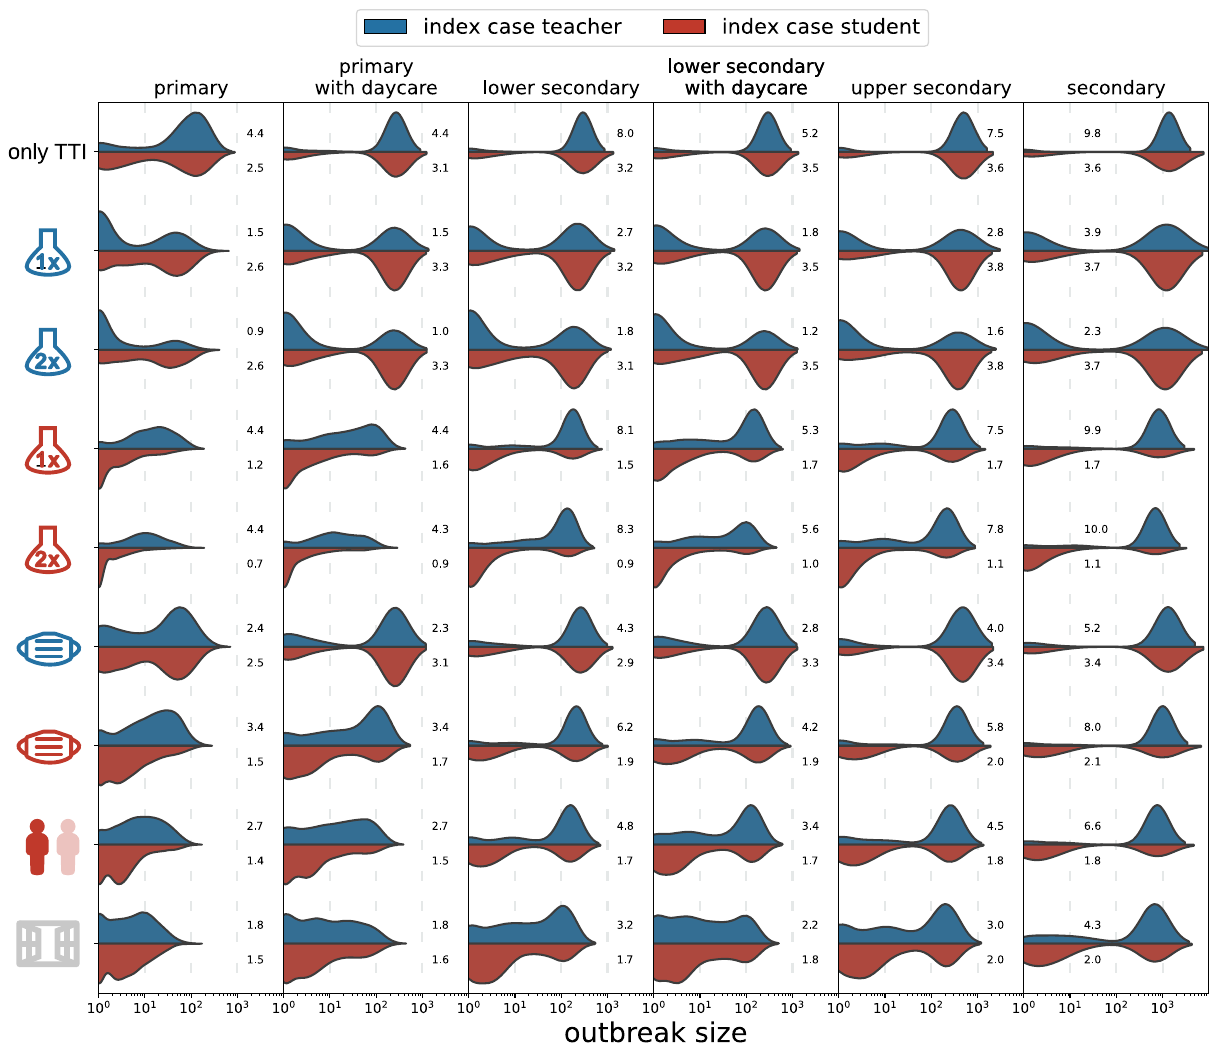
Fig. 3 Distributions of cluster sizes for different school types (columns) and measures (rows) with teachers (blue) or students (red) as the source cases. Results are shown for only test-trace-isolate (TTI) as baseline and TTI plus an individual measure (testing teachers/students once or twice a week, teachers or students wearing masks during the lessons, class size reductions, ventilation), respectively. Mean values of R are shown next to the distributions.